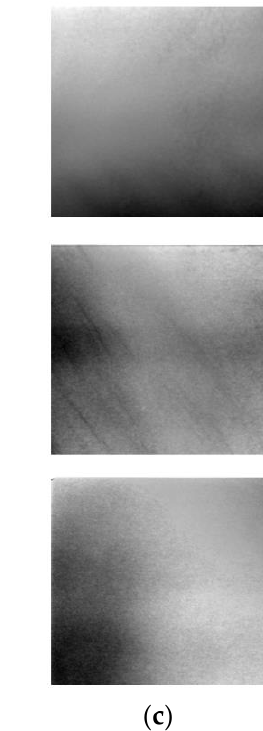
Figure 1. Three typical normal samples. ( a ): brighter normal samples ( b ): normal samples with false defects ( c ): normal samples with missing details.